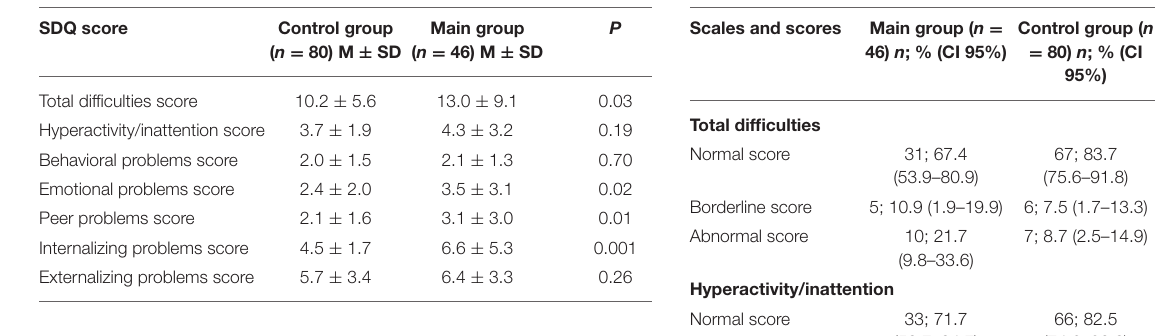
TABLE 1 | SDQ score for psychosocial problems in children with GHD and in the control group.